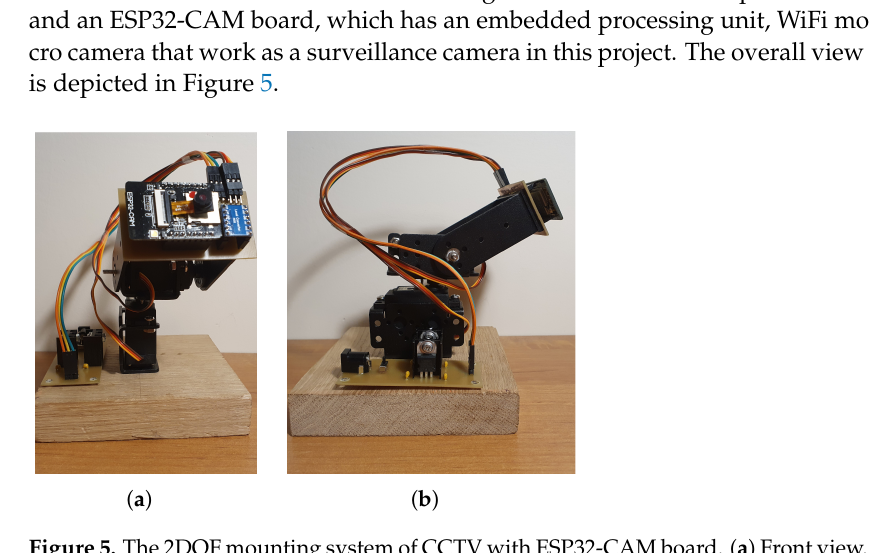
Figure 5. The 2DOF mounting system of CCTV with ESP32-CAM board. ( a ) Front view. ( b ) Side